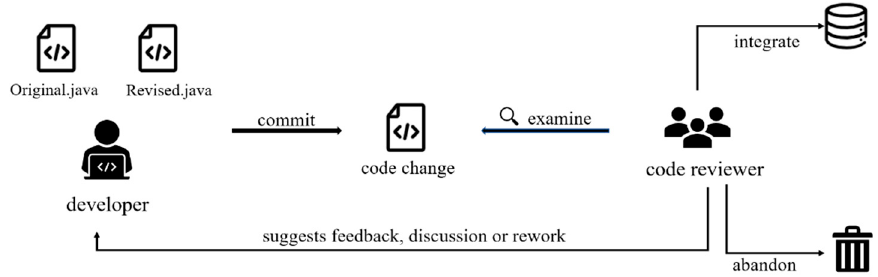
Figure 1. The process of code review.